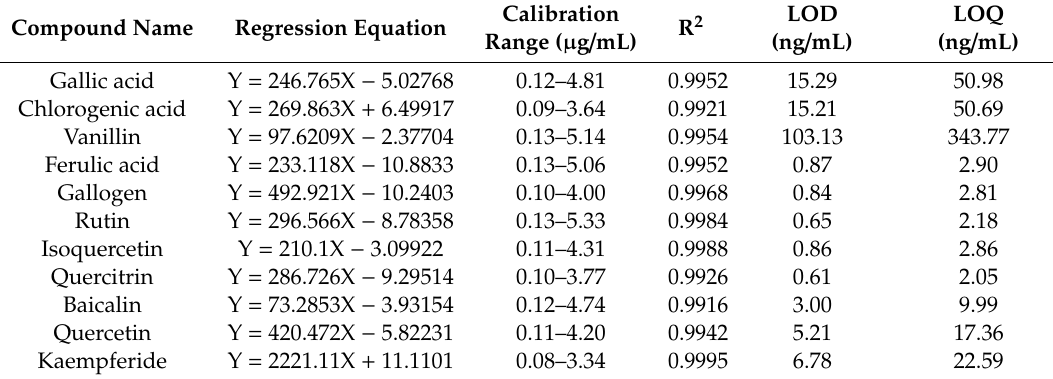
Table 2. Analytical performance data of polyphenols by UPLC-ESI-MS / MS.